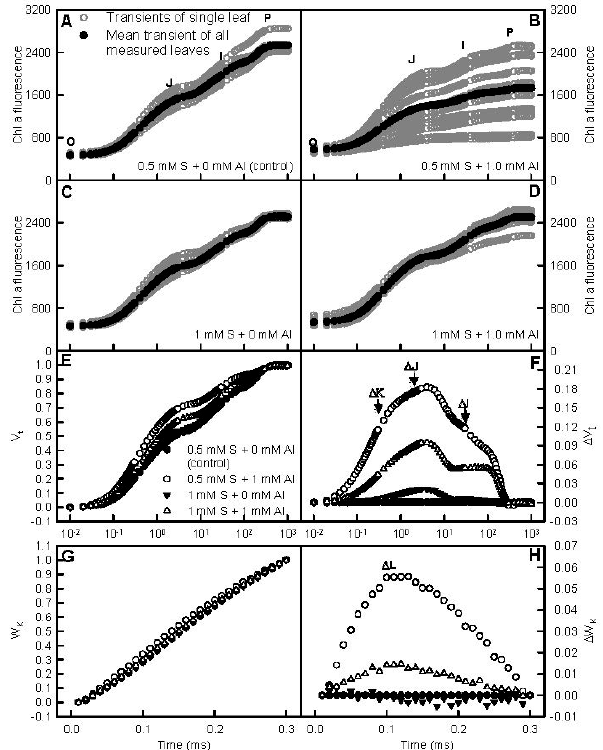
Figure 3. Effects of S and Al interactions on high irradiance actinic-light-induced OJIP transients of dark-adapted leaves ( A – D ) and the different expressions derived from the mean transients in dark-adapted leaves: ( E ) between F o and F m : V t = (F t − F o )/(F m − F o ) and ( F ) the differences of the four samples to control; ( G ) between F o and F 300 μ s : W K = (F t − F o )/(F 300 μ s − F o ) and ( H ) the differences of the four samples to control.